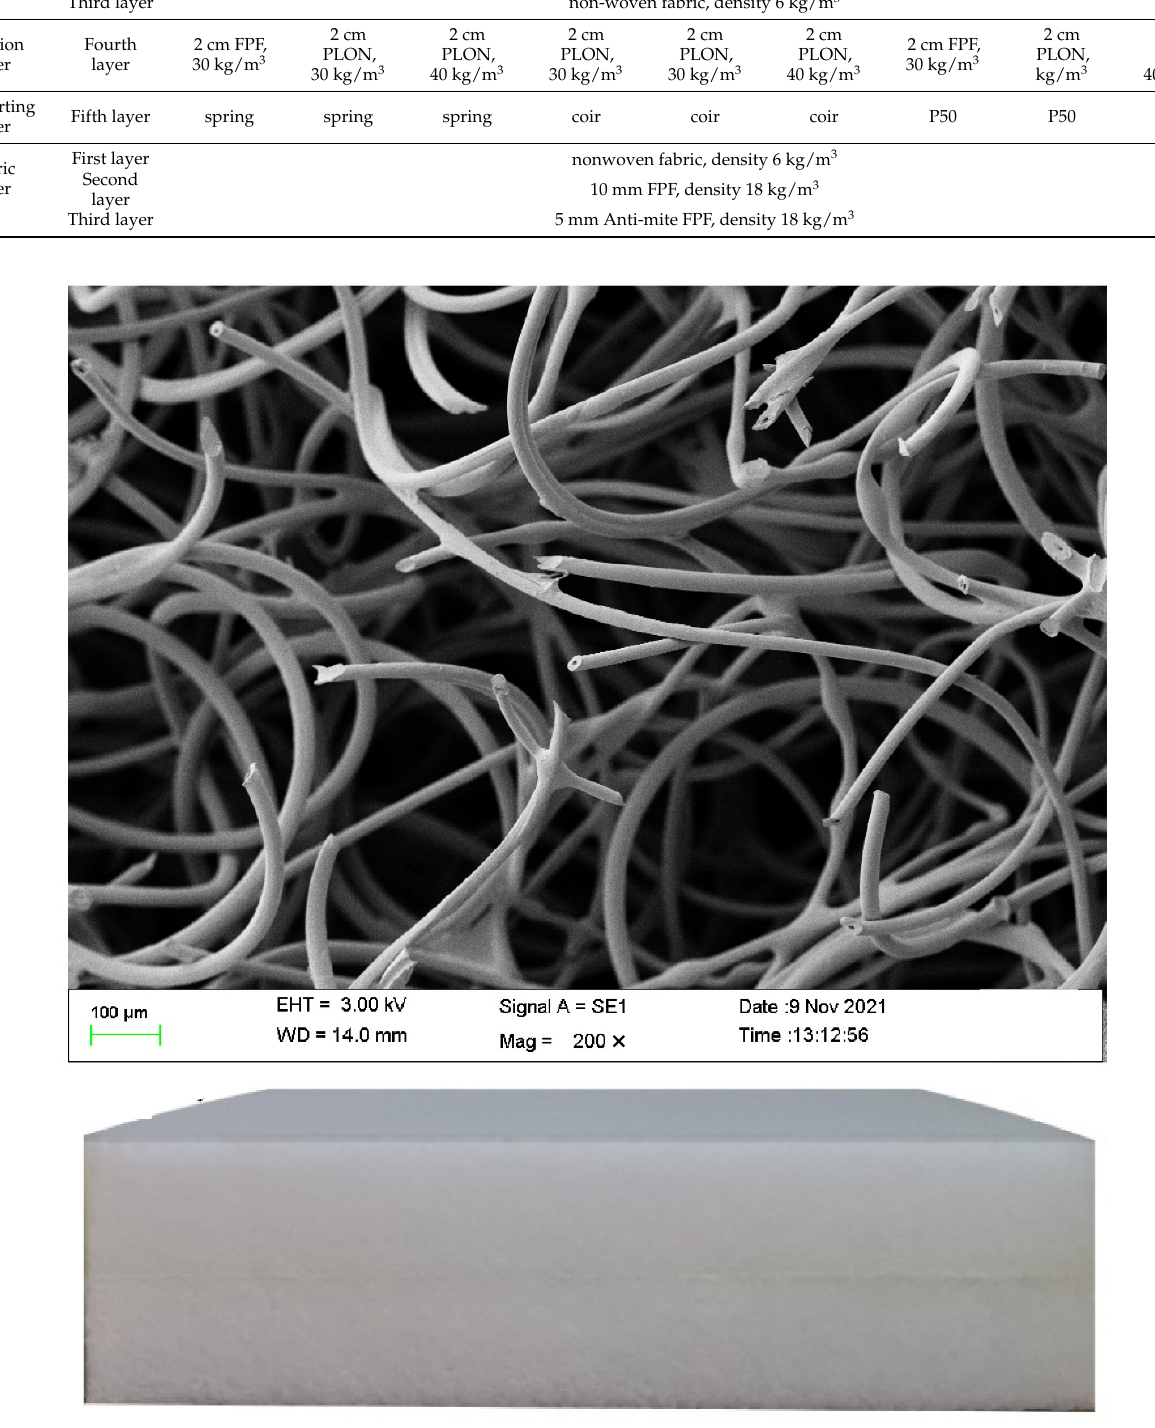
Figure 2. Scanning electron microscope (SEM) figure physical appearance of PLON blocks.